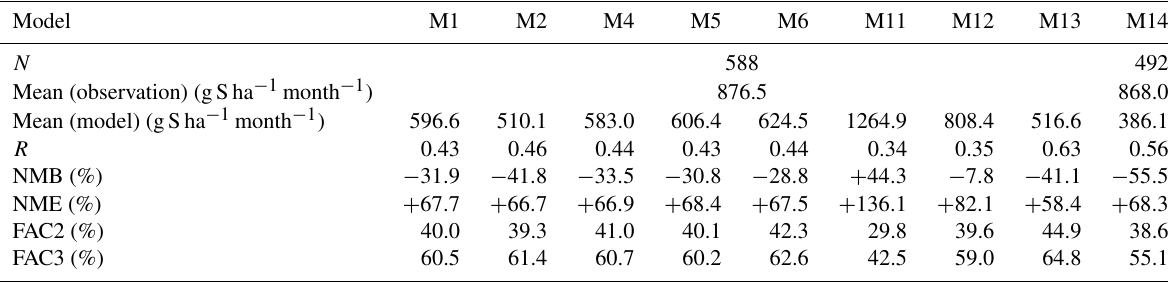
Table 3. Summary of statistical analysis of model performance for the wet deposition of S. Model Mean (observation) (gSha − 1 month − 1 )